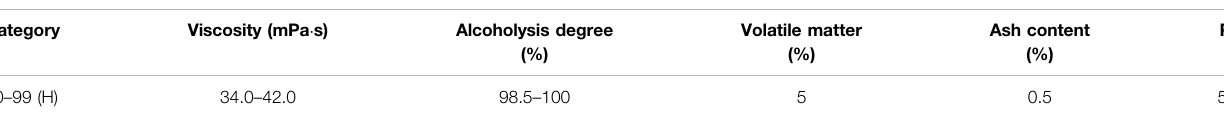
TABLE 1 | Physical properties of polyvinyl alcohol (PVA) for